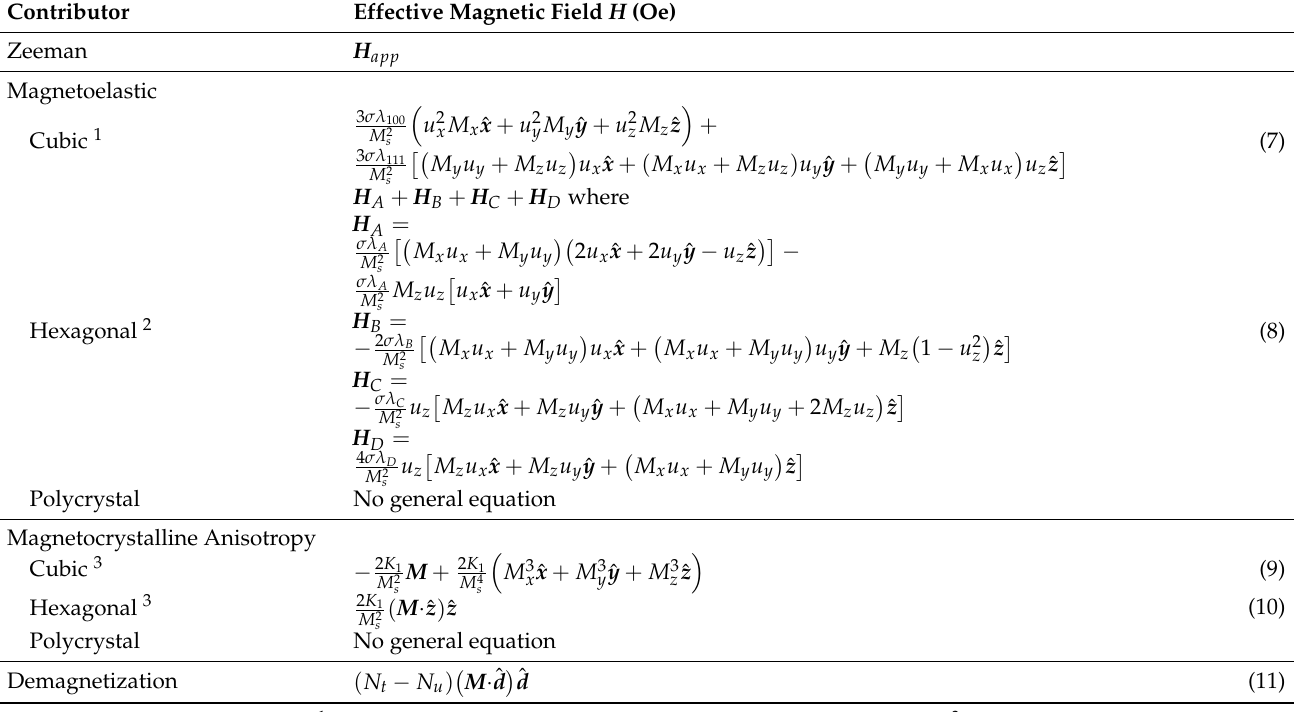
Table 1. Effective magnetic field